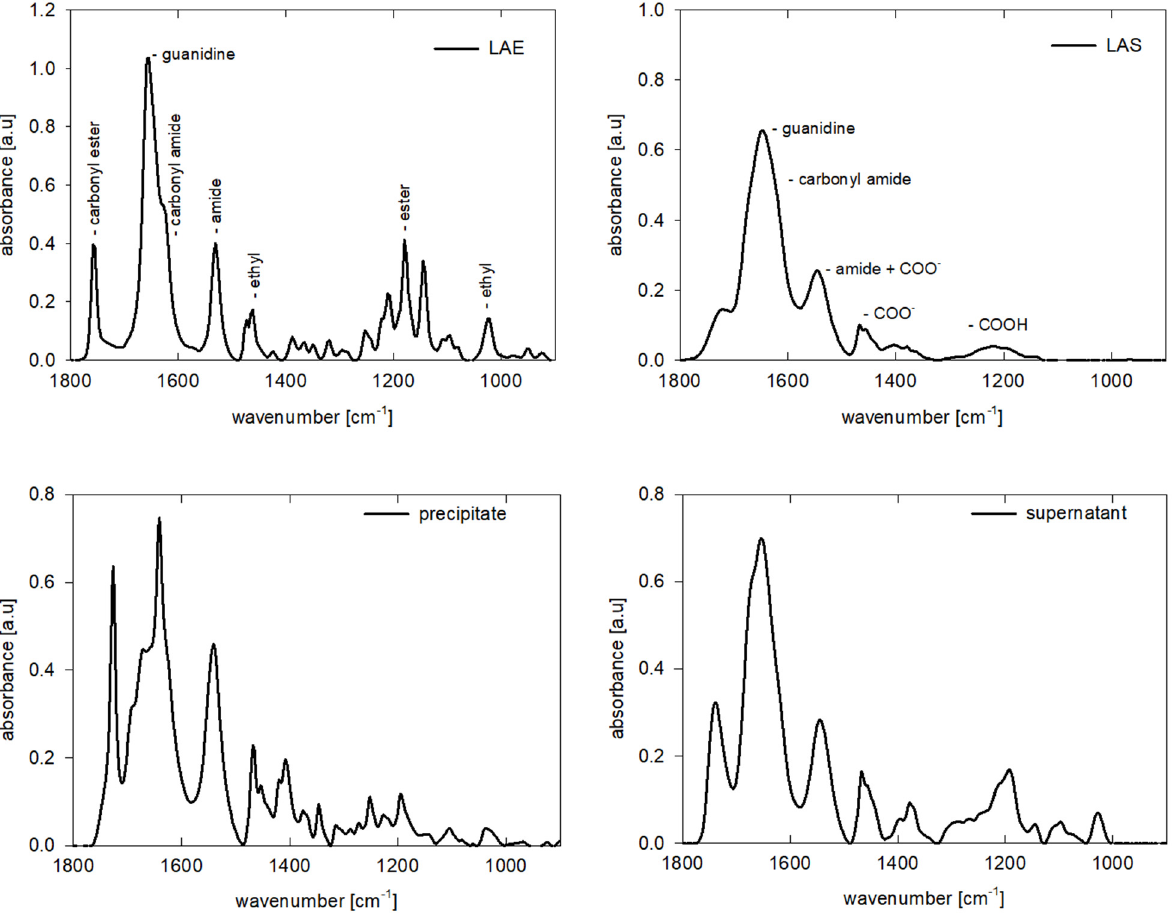
Figure 9. IR spectra of fresh LAE and LAS solutions and of “stored” LAE, precipitate and supernatant phase.